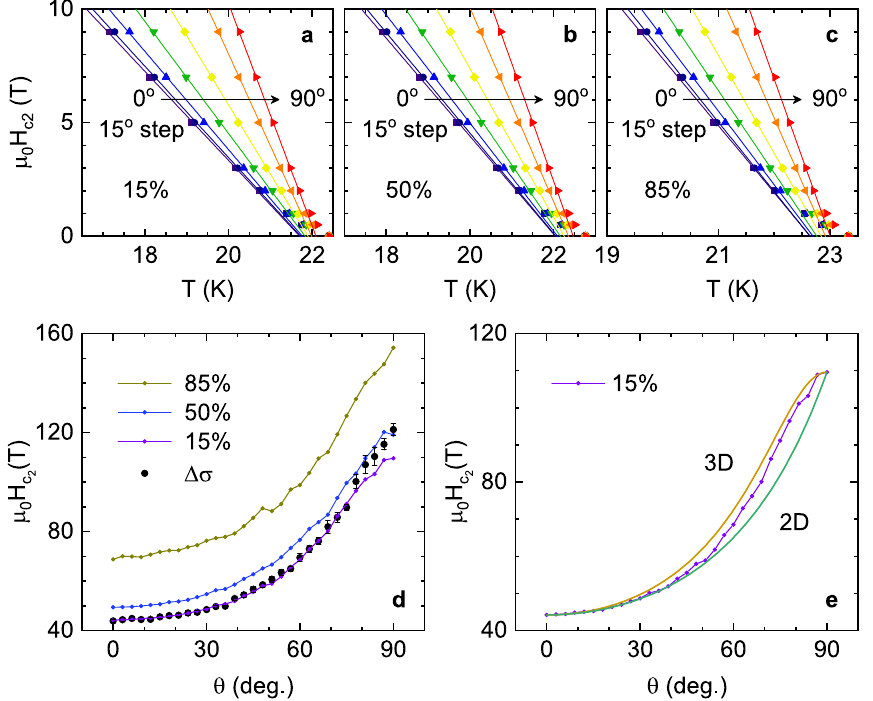
Figure 4. ( a – c ) H c 2 ( T ) θ calculated as the magnetic field and temperature pairs at which the resistivity falls to a given percentage of the background resistivity at T c . The behavior is linear up to very close to T c (within the resistive transition width), where a T c distribution may strongly affect the ρ( T ) H , θ behavior. The extrapolation to 0 K is presented in ( d ), where it is shown that no criteria match the result from the �σ analysis (black circles), which shows a more pronounced maximum close to 90 ◦ . In ( e ), it is shown that the H c 2 resulting from a criteria neither follows the 3D-aGL angular dependence.